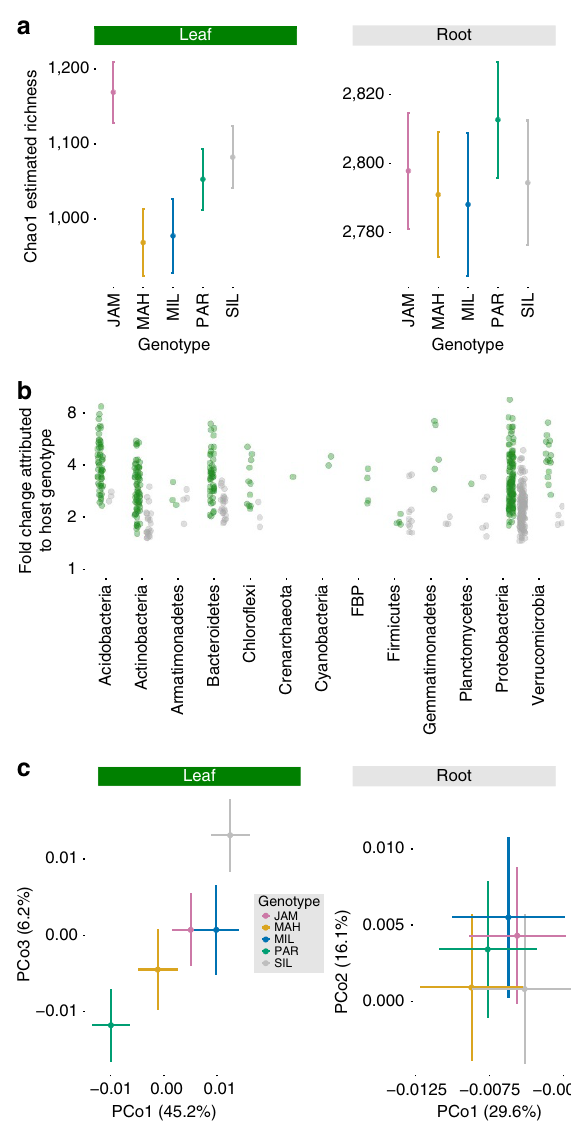
Figure 5 | Host genotype shapes a and b diversities of the leaf microbiome but has weaker effects on root communities. The results shown here represent only the constitutive or environment-independent component of genetic variation, that is, genotype differences averaged across all sites. Sample sizes are N ¼ 306 for leaves and N ¼ 310 for roots. ( a ) Least- squares mean estimates of within-sample diversity are plotted for each plant genotype, after controlling for other sources of variation using linear mixed effects models. Leaves: F 4,265 ¼ 4.68, P ¼ 0.0023; Roots: F 4,261 ¼ 0.344, P ¼ 1. Bars depict 1 s.e.m. ( b ) Each point is an estimated differential abundance of one OTU between a pair of plant genotypes, plotted as a fold change (note log scale on vertical axis). Leaf OTUs are shown in green, root OTUs in grey. Differential abundance estimates and statistical significance were both generated using variance-stabilized NBMs that also controlled for site, year of observation, plant age, genotype-by-site interaction, age-by-site interaction and year-by-site interaction. Only statistically significant contrasts are shown (Wald test, P o 0.05 after Benjamini–Hochberg correction for multiple comparisons). ( c ) Bacterial community composition separates by host plant genotype in weighted UniFrac ordination for leaves, but not roots. Least-squares mean PCoA coordinates are plotted to highlight the influence of host genotype after controlling for other sources of variation using LMMs. Detailed statistics for each PCoA axis are found in Table 2. Bars depict one standard error of the